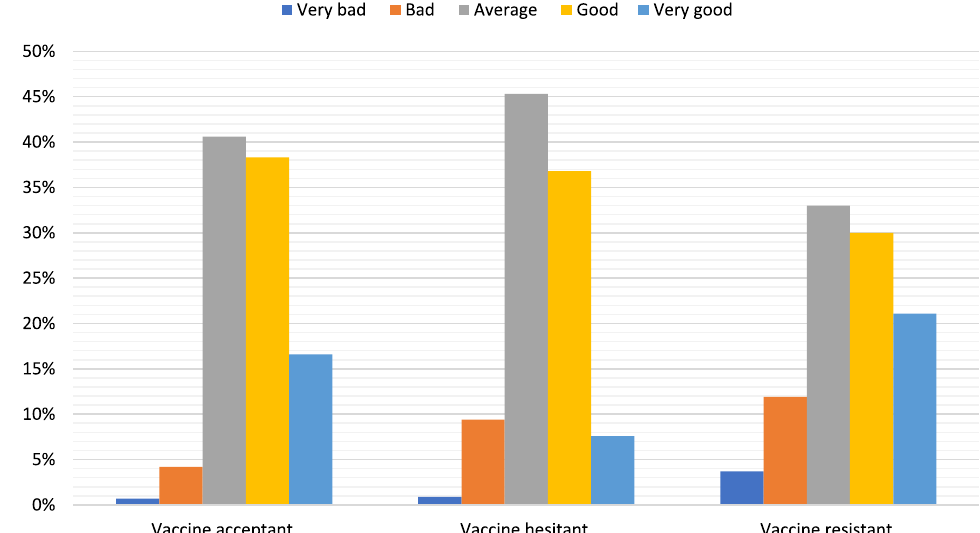
Fig. 2 Self-rated knowledge level about COVID-19 among university students ( n